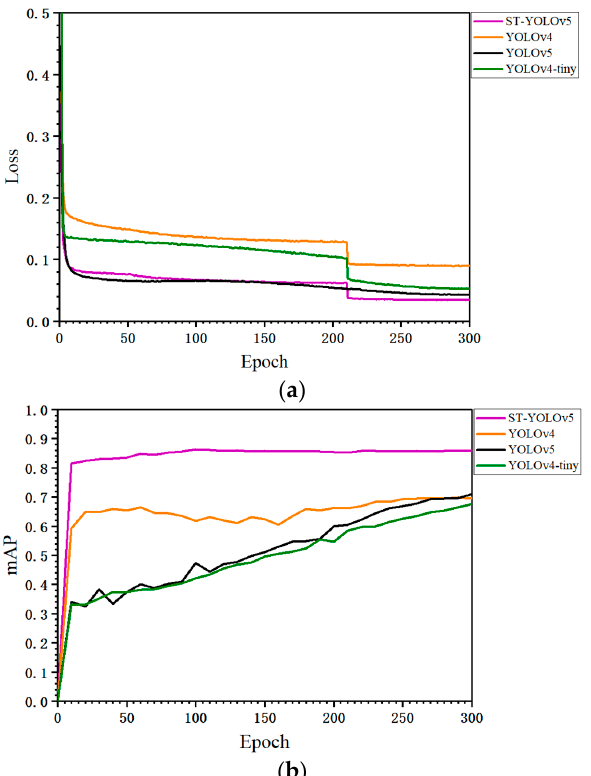
Figure 13. Comparison of different algorithms. ( a ) Comparison of loss values. ( b ) Comparison of detection and classification effects.